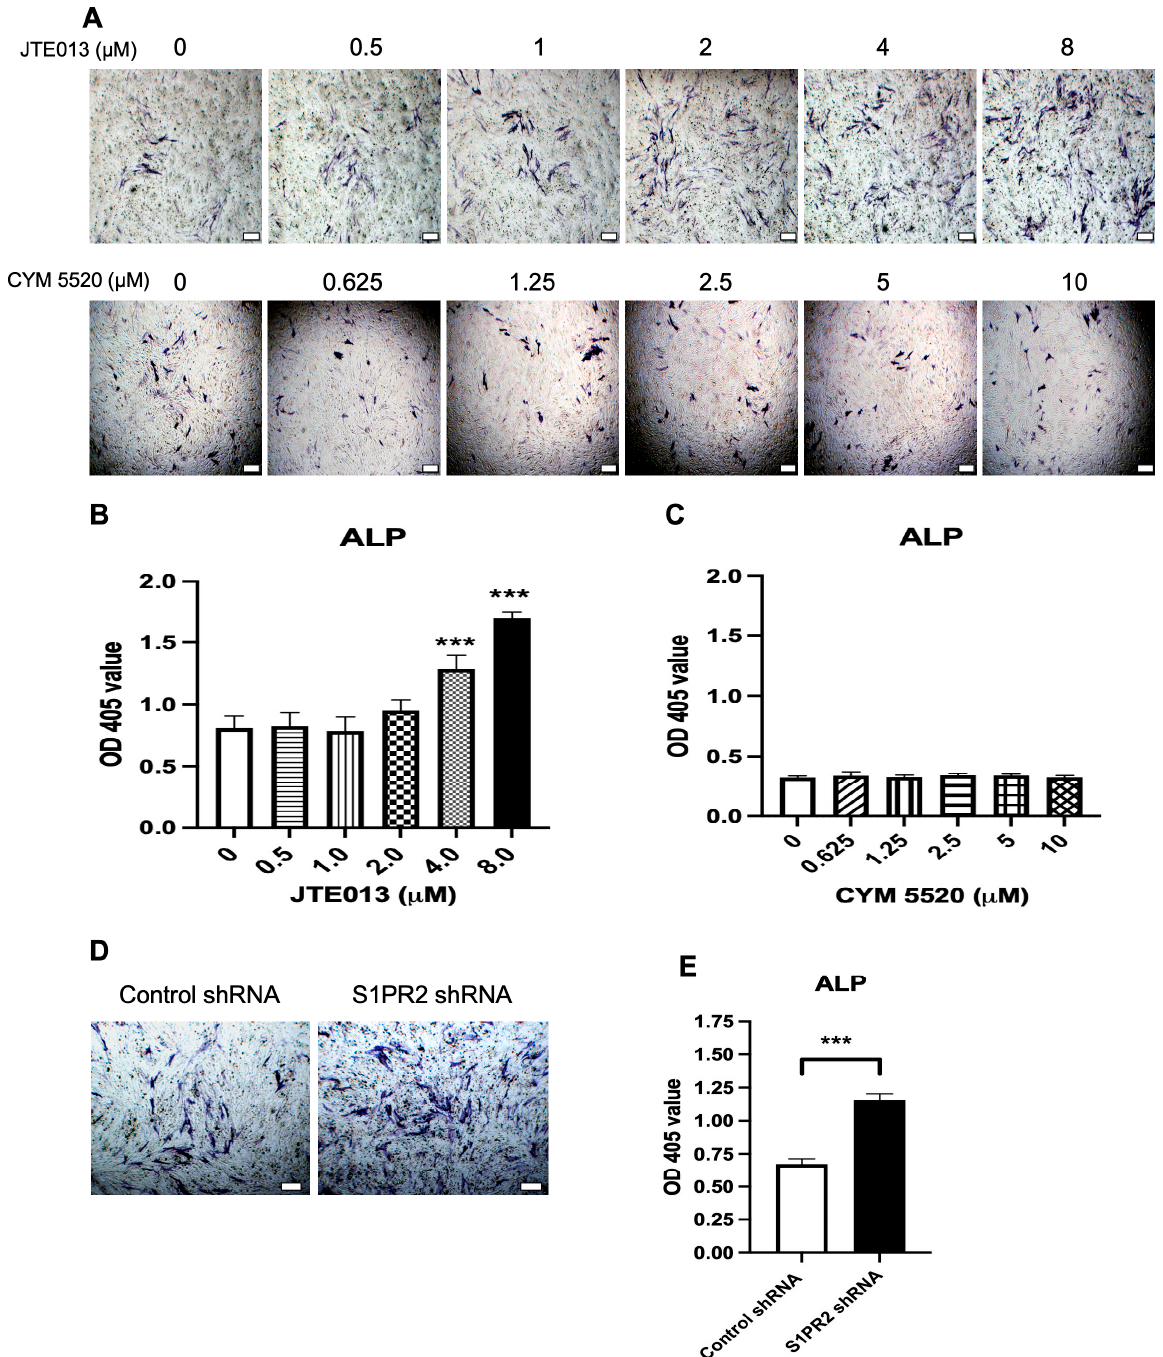
Figure 2. Effects of a S1PR2 antagonist (JTE013), a S1PR2 agonist (CYM 5520), a control shRNA, or a S1PR2 shRNA on alkaline phosphatase (ALP) staining in murine BMSCs. Murine BMSCs were cultured in osteogenic media with either vehicle (DMSO), JTE013 (0.5 to 8 μ M), CYM5520 (0.625 to 10 μ M), a control shRNA, or a S1PR2 shRNA for 7 days. ( A ) Representative images of ALP staining in murine BMSCs treated with DMSO, JTE013, or CYM5520. ( B ) Quantification of ALP staining in murine BMSCs treated with DMSO or JTE013 (n = 3, *** p < 0.001). ( C ) Quantification of ALP staining in murine BMSCs treated with DMSO or CYM 5520. ( D ) Representative images of ALP staining in murine BMSCs treated with either a control shRNA or a S1PR2 shRNA. ( E ) Quantification of ALP staining in murine BMSCs treated with a control shRNA or a S1PR2 shRNA. All images were taken under 40× magnification. Scale bars represent 200 μ m. For quantification of ALP staining, the OD405 value was calibrated by protein concentration in cell protein lysates (n = 3, *** p < 0.001).